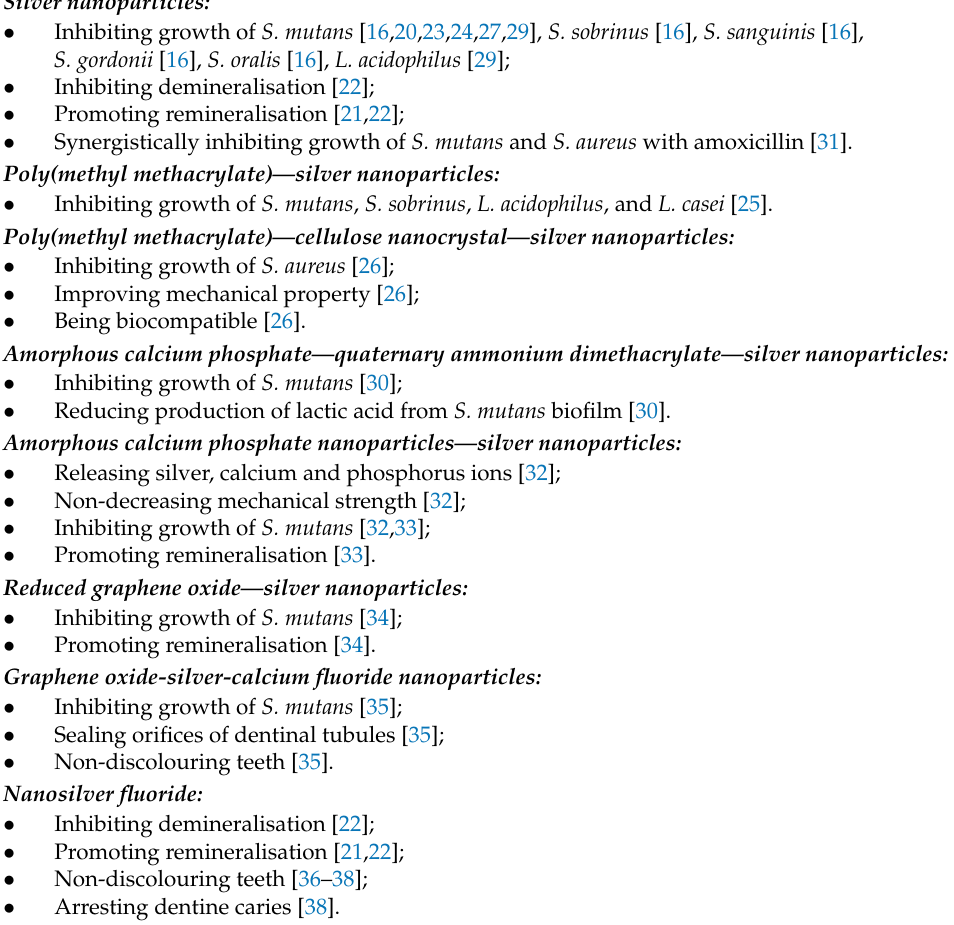
Table 1. Properties of silver nanoparticles and their related products in caries